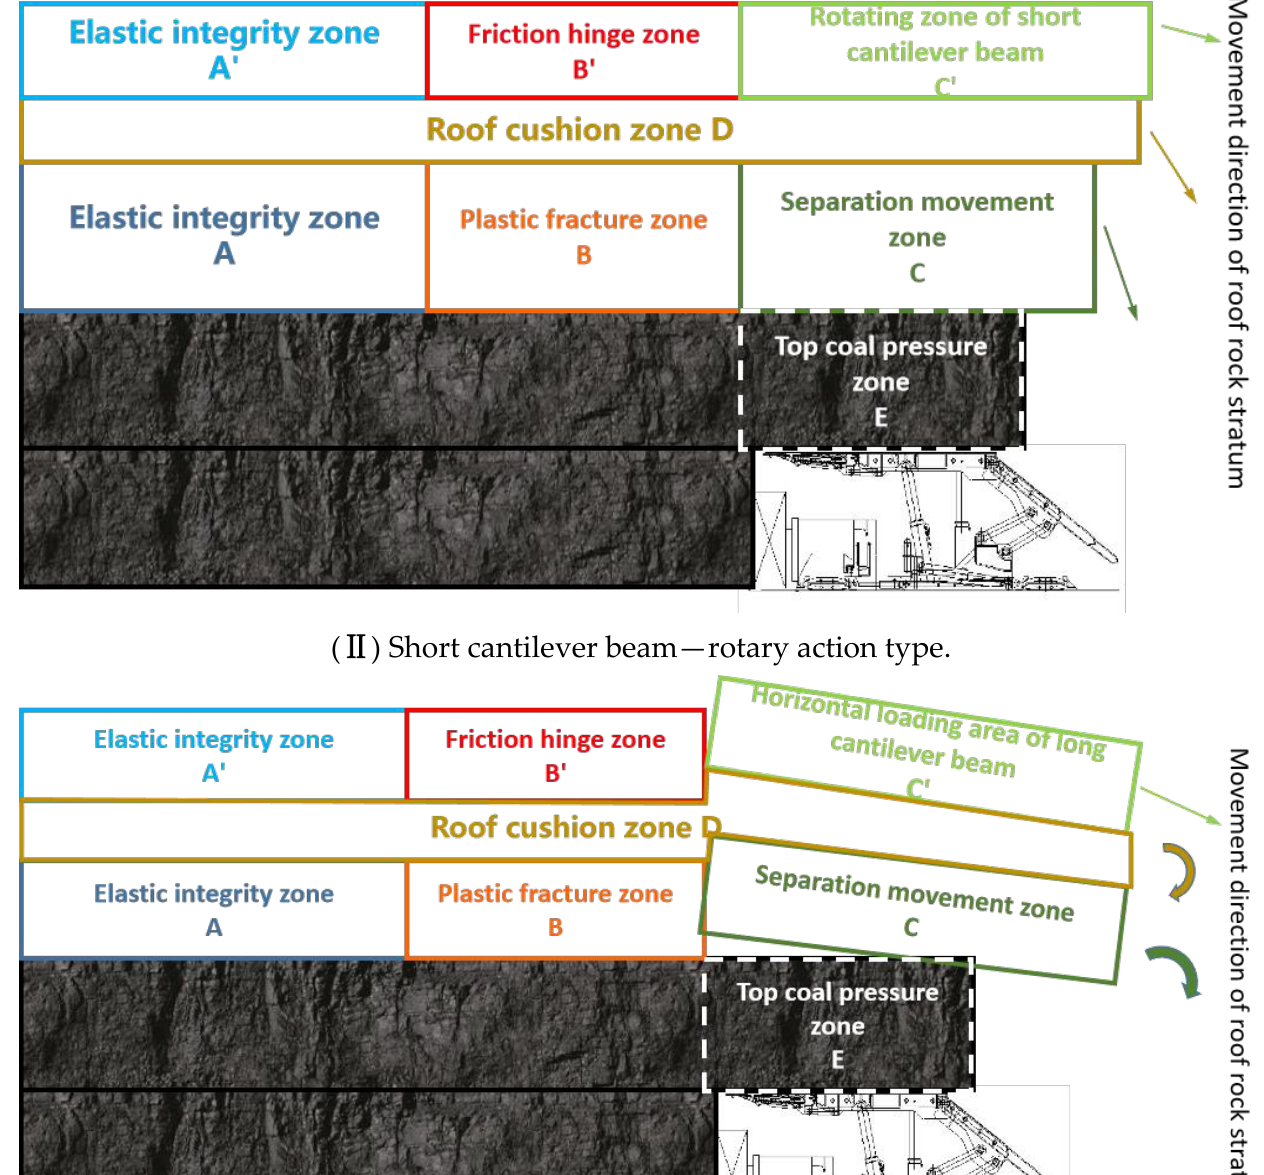
where q is the second root of the ratio of the first and third invariants of the partial stress tensor s; J and the biaxial and uniaxial compressive yield stress σ ’ are about [ J =( σ ’ − 1 )/(2 σ ’ − 1 )] ； < σ > is the symbol of the Macaulay matrix operation; σ t is the tensile stress, MPa,